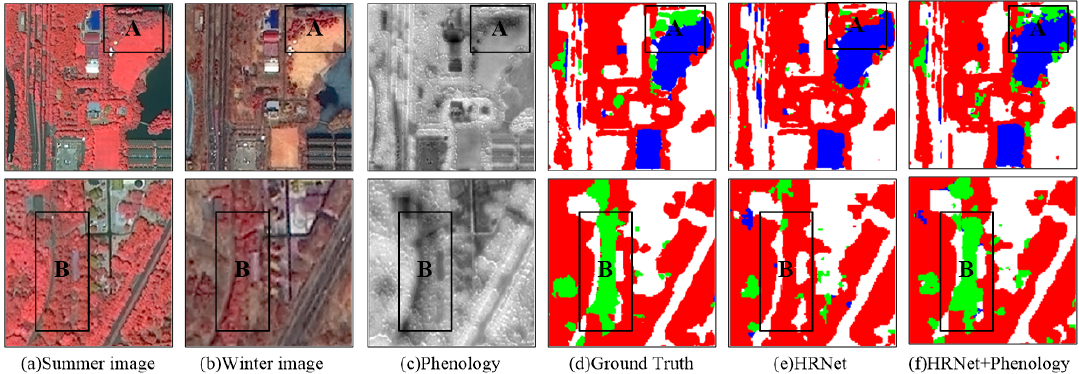
Figure 8. Comparison of the results of the methods with and without the phenology